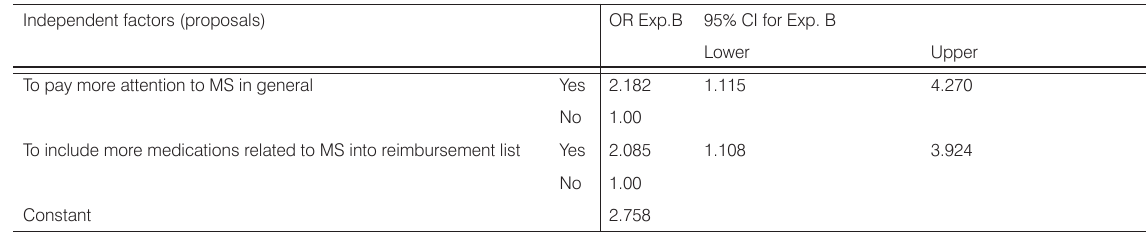
Table 5. Relation between depression and